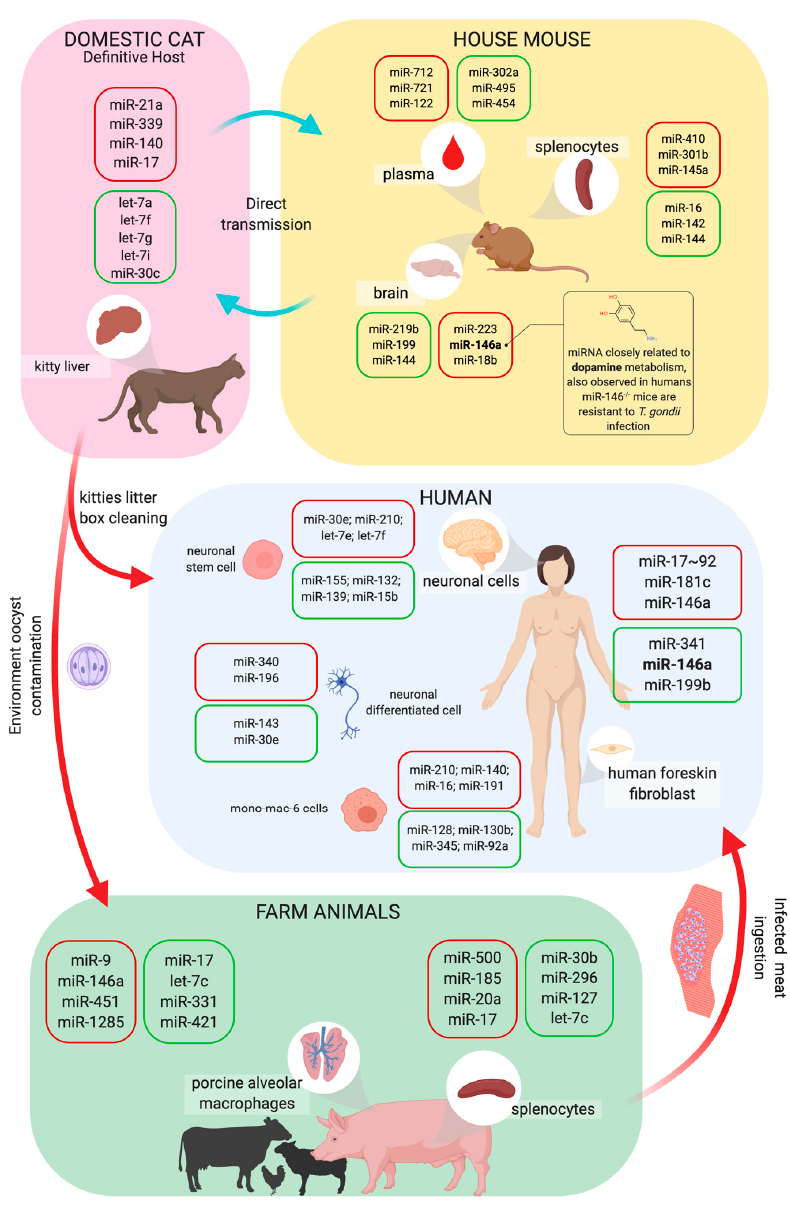
Figure 4. Life cycle of Toxoplasma and host miRNA interaction. Toxoplasma gondii has a complex life cycle, in which the parasite can infect a large range of animals, such as domestic cats, farm animals, mice, and even humans. Cats are the T. gondii definitive host. Oocysts are released from infected cats’ feces, sporulate in the environment, and become infective. Samples of kittens’ liver present modifications in miRNA expression. Humans can also become infected by eating undercooked meat of infected animals or while nursing infected cats. In the human host, this infection can lead to toxoplasmosis, a disease that affects various organs’ tissues such as skeletal muscle, myocardium, and the brain. As a result, neuronal cells, monocyte/macrophage, and fibroblasts from infected patients present modifications in miRNA expression. Also, porcine alveolar macrophages and splenocytes samples have altered miRNA profiles in infected pigs. To study toxoplasmosis in vivo, mice models are commonly used because mice can naturally be infected by the parasites and affect multiple organs while changing their miRNA profile. Mice are largely used to study the disease outcomes and treatments, they can also be naturally infected and have multiple organs affected with the infection, and it is already known that the spleen, plasma, and brain have their miRNA profile changed during the infection. The box color represents the increase (red) or decrease (green) of miRNAs expression.